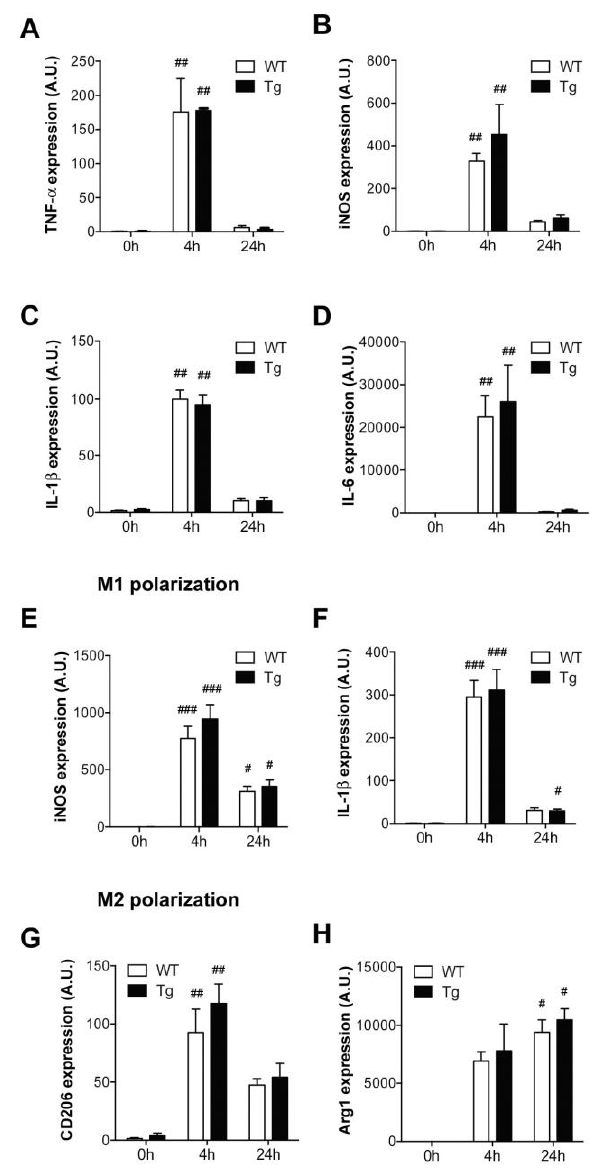
Figure 3. Activation profile of macrophages in hORMDL3 Rosa26 mice. ( A – D ) Gene expression of activation markers analyzed by real-time PCR in BMDM macrophages from WT and Tg mice at indicated time points upon LPS (100 ng/ml) treatment. ( A ) TNF- α , ( B ) inducible nitric oxide synthase (iNOS), ( C ) IL-1 β , and ( D ) IL-6. ( E , F ) Effect of 100 ng/mL LPS and 30 ng/mL INF- γ on M1 polarization, according to iNOS ( E ) and IL-1 β ( F ) expression. ( G , H ) Effect of 20 ng/mL IL-4 on M2 polarization, according to CD206 ( G ) and Arg1 ( H ) expression. Data are normalized to GAPDH. Statistics: n = 4–8 Kruskal-Wallis test compared to time 0; # p < 0.05, ## p < 0.01; ### p < 0.001. Error bars represent standard error.